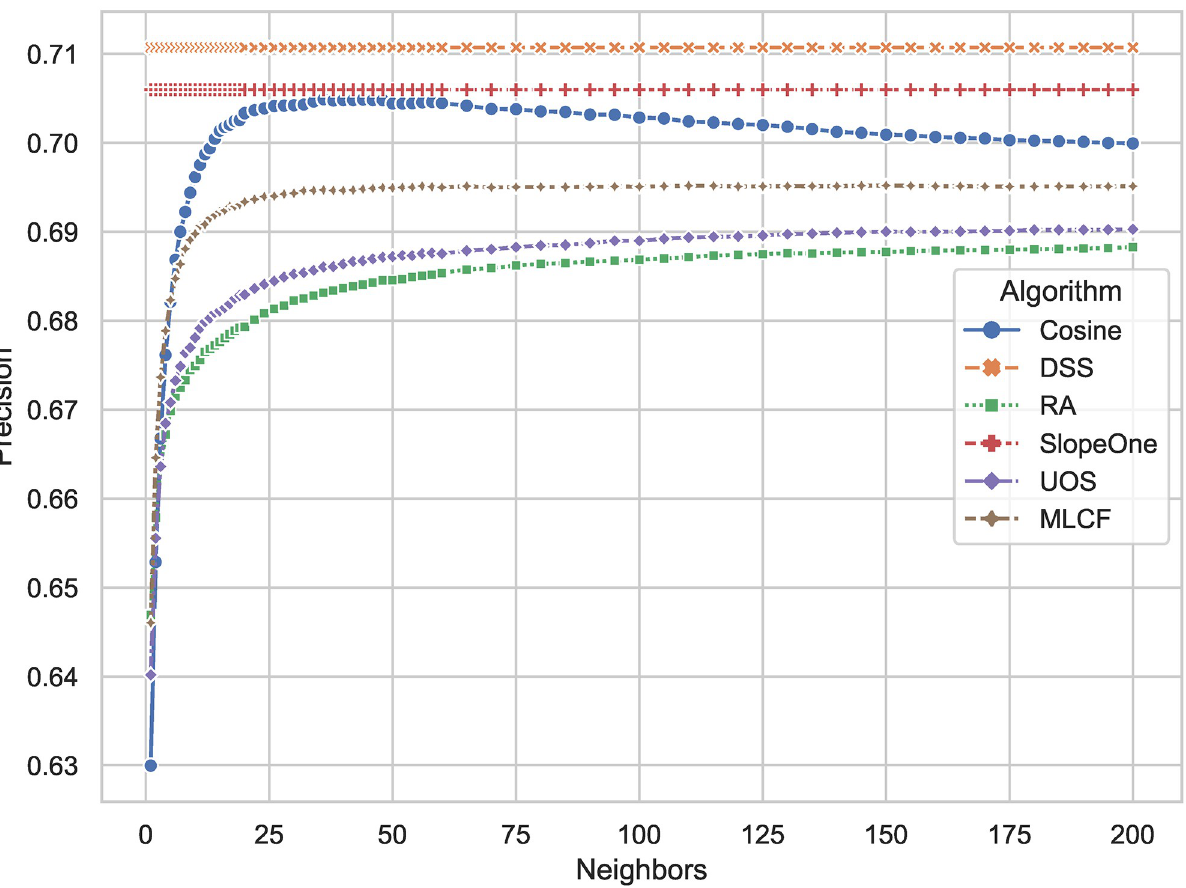
Fig 9. Precision results of different algorithms. The larger the result, the less false positives the algorithm has in predicting user preferences, and the less likely the algorithm is to put items that the user does not like into the recommendation list.